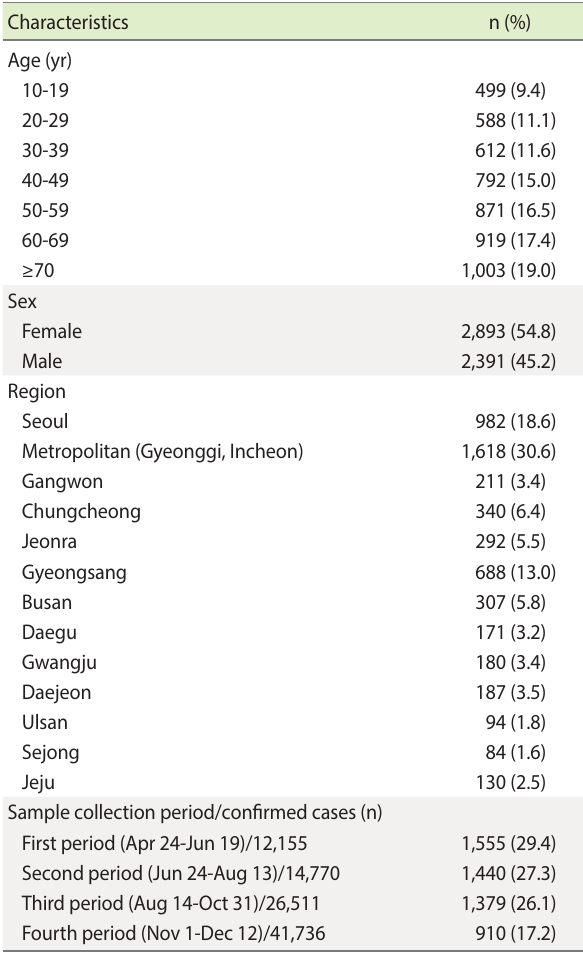
Table 1. General information of subjects (n=5,284) Characteristics